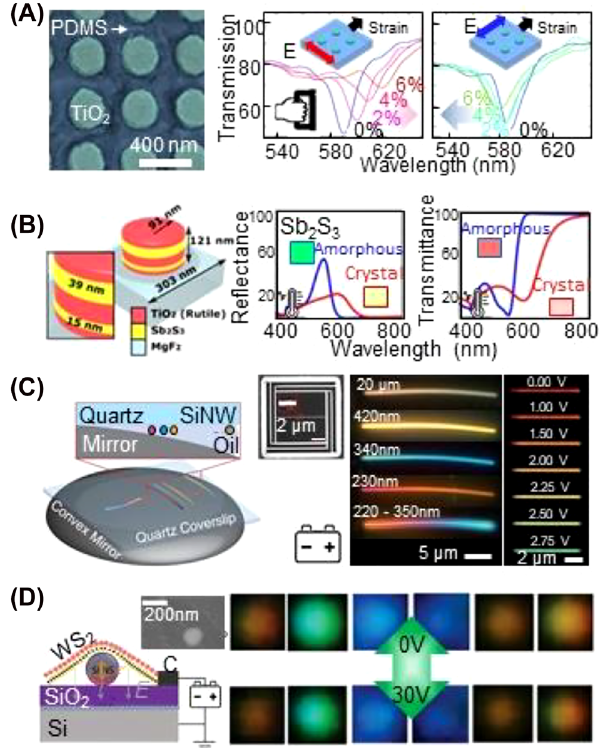
Figure 7: Various responsive Mie resonance nanopixels